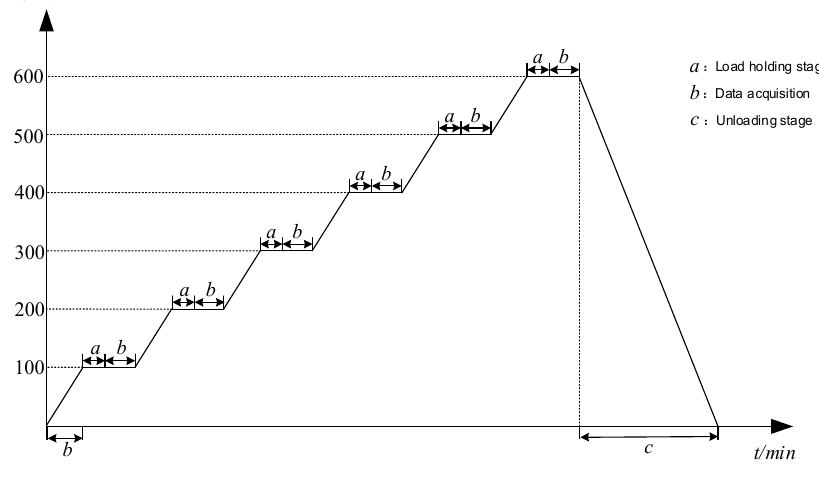
Figure 4. Test loading protype.